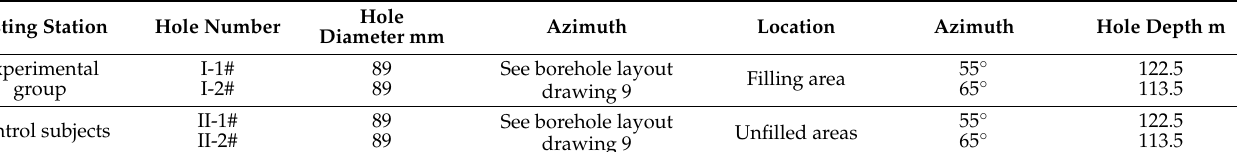
Table 3. Borehole Characteristics.